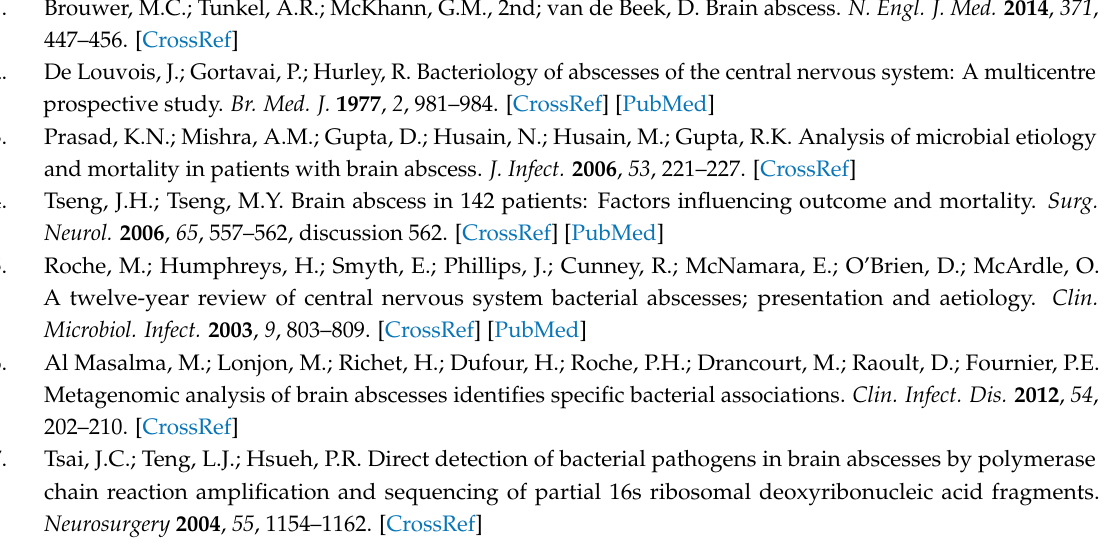
s1, Figure S1: Taxonomic classification of metagenomic data using partial alignment ratio and read length, Figure S2: Average nucleotide identity analysis of Prevotella sp. TCVGH, Table S1: Sequencing data from Illumina MiSeq, Table S2: MinIon Nanopore sequencing data, Table S3: COG functional CDS of Prevotella sp. microbial composition, Table S6: Metagenome analysis of fungal composition, Table S7: Metagenome analysis of viral composition, Table S8: Antimicrobial susceptibility testing of Streptococcus constellatus TCV107, Table S9: Antimicrobial susceptibility testing of Prevotella sp. TCVGH, Table S10: Predicted virulence gene in Streptococcus constellatus TCV107, Table S11: Comparison of metagenomic analysis in the study with previous study. Author Contributions: Conceptualization, C.-L.W., Y.-T.H. and P.-Y.L.; Formal analysis, Z.-Y.W., Y.-T.H.